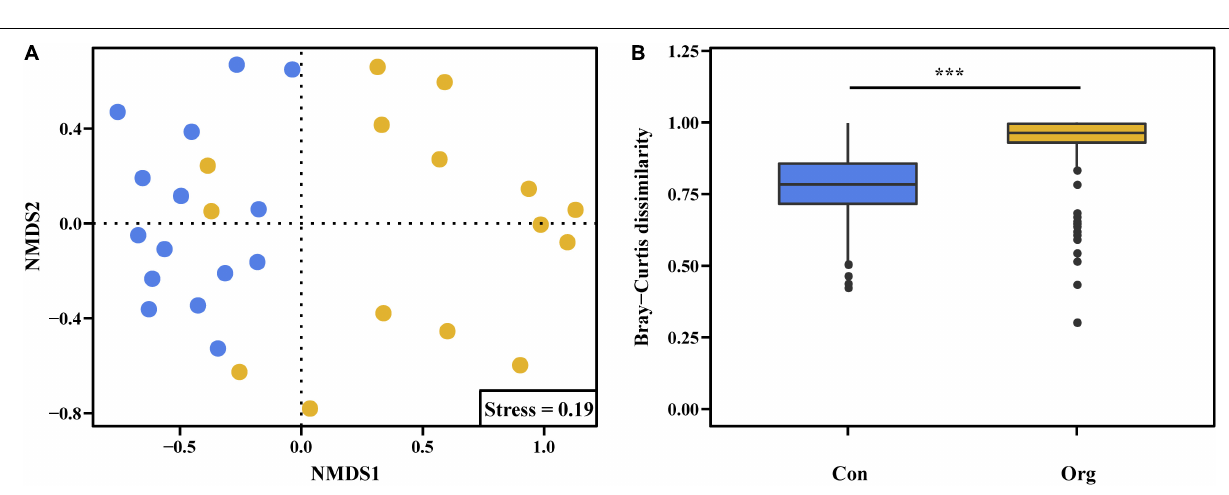
FIGURE 5 | Non-metric multidimensional scaling ordinations (A) of AM fungal communities on conventional (blue) and organic (yellow) farms based upon their OTU composition derived from Bray-Curtis distances (B) . The *** represents the difference between the two farming systems is significant at P = 0.001 level.